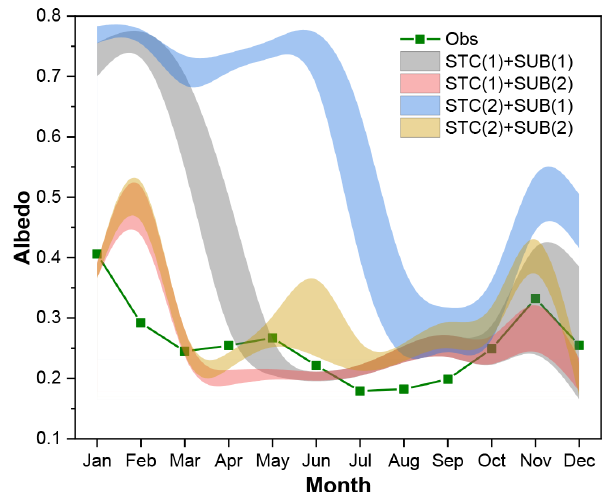
Figure 9. Uncertainty interval of ground albedo at the TGL site in the dominant physical processes (STC and SUB) for SCE simula-